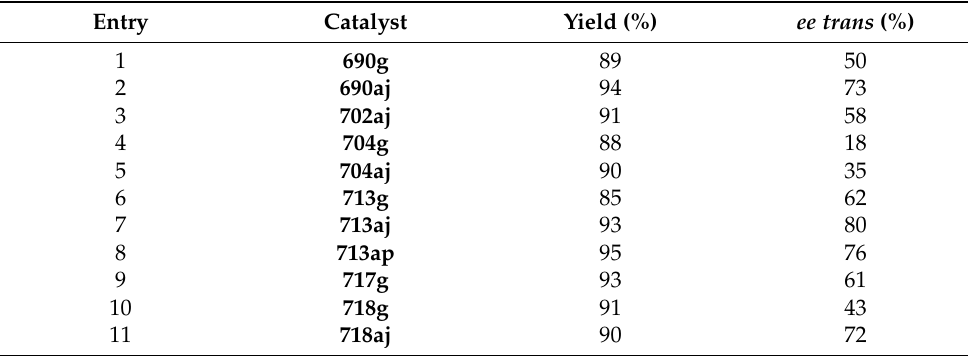
Table 6. The Michael-initiated ring closure reaction shown in Scheme